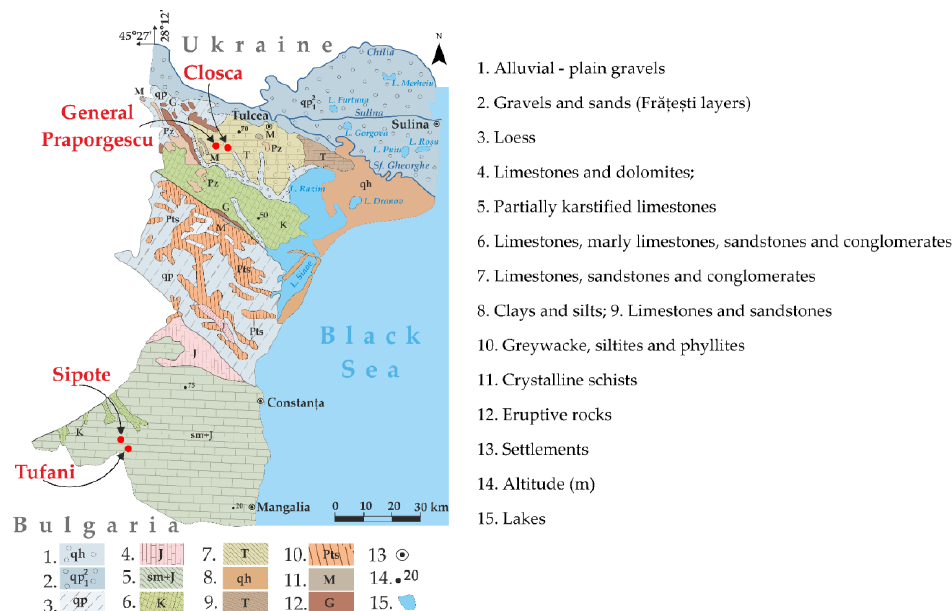
Figure 2. Hydrogeological map of Dobrogea (modified after Ghenea) [32].